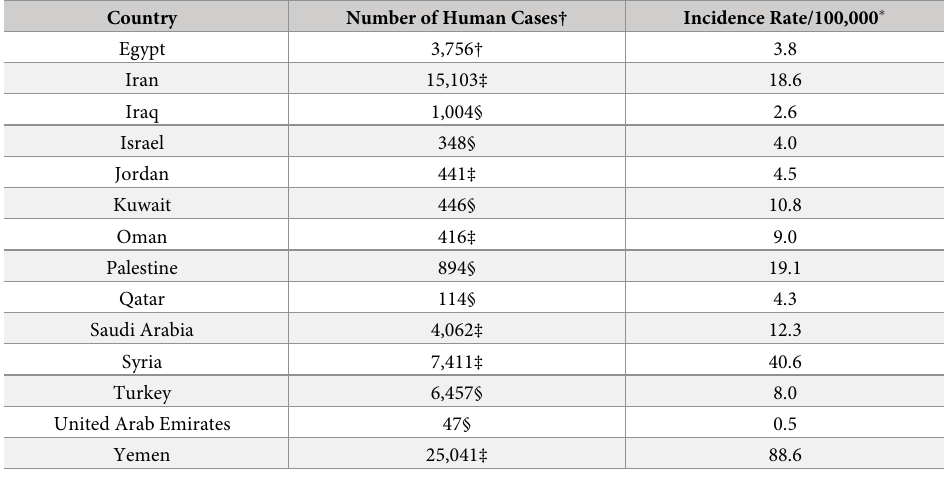
Table 2. Annual numbers of human brucellosis cases reported in some ME countries in recent